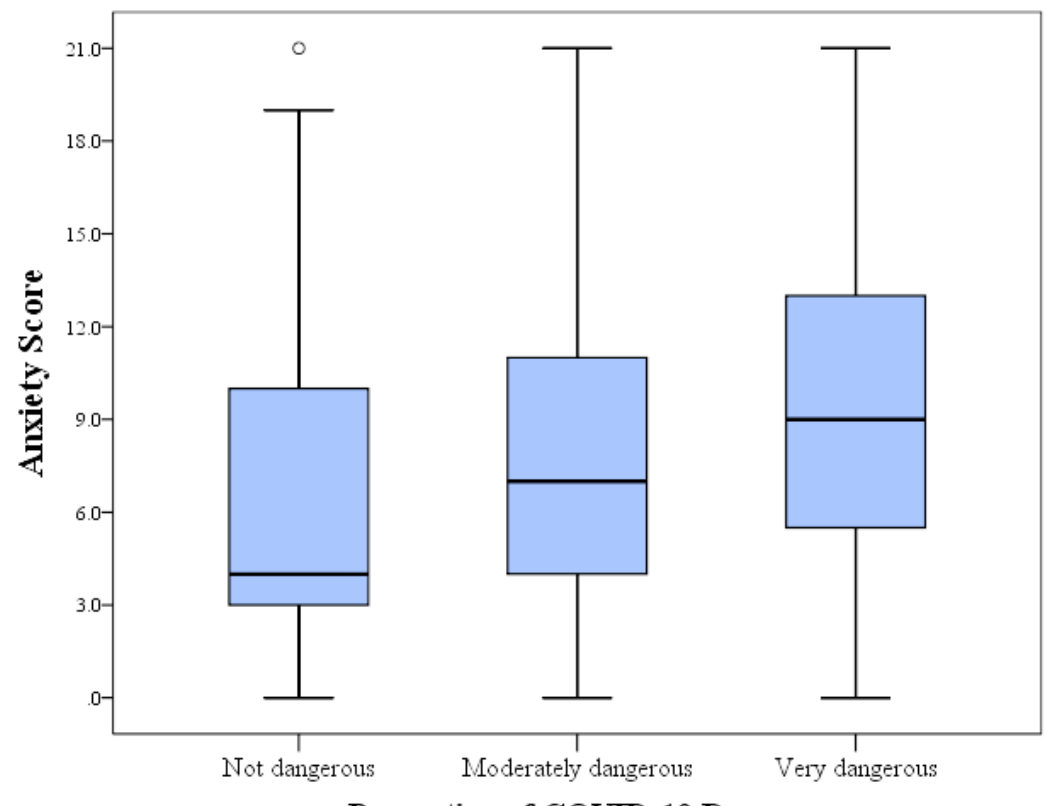
Figure 1. Anxiety score distribution among the study participants stratified by attitude towards COVID-19 perceived danger. Gradual increase in anxiety was seen among students at the University of Jordan in relation to their perception of coronavirus disease 2019 (COVID-19) danger. The difference was statistically significant ( p < 0.001, Kruskal–Wallis test).